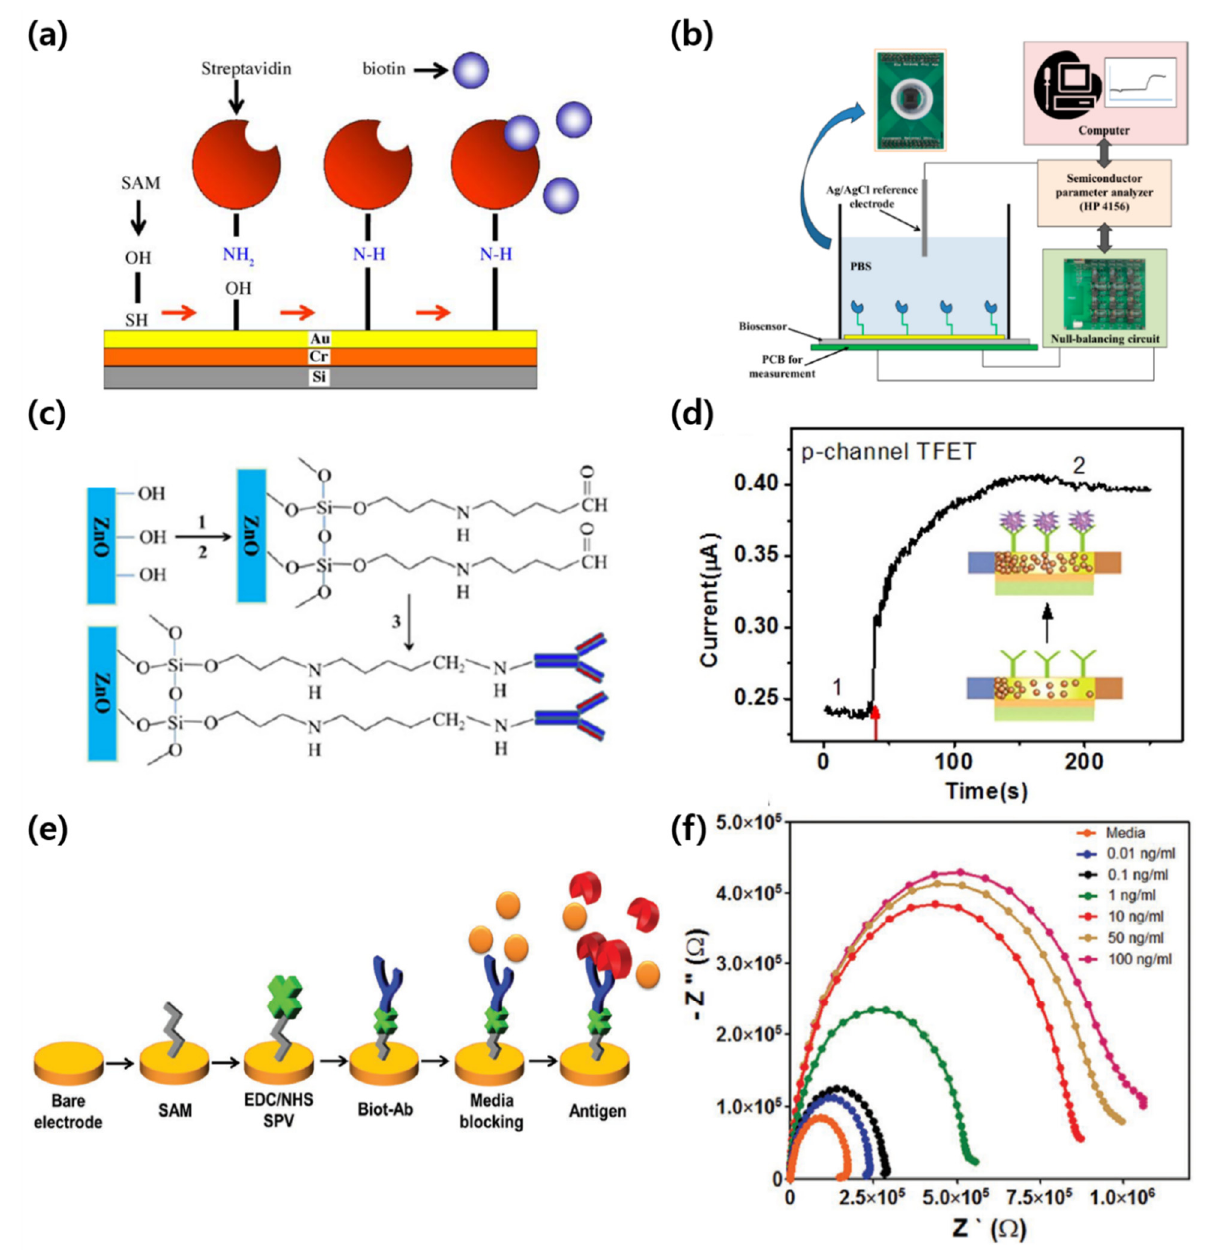
Figure 8. SAMs as a linker in biosensors. ( a ) Schematic of the immobilization sequence of streptavidin and the interaction between streptavidin and biotin (adapted from [93] with permission from Elsevier). ( b ) Measurement setup to detect C-reactive protein (adapted from [94] with permission from MDPI). ( c ) Immobilization of uricase onto the ZnO NW surface via the crosslinking surface modification method: (1) 2% APTES in ethanol; (2) 25 wt% GAD; (3) 5 μ L uricase (5 units/mL) (adapted from [88] with permission from Elsevier). ( d ) Electrical characteristics of an SiNW-TFET based biosensor detecting CYFRA21-1 (adapted from [85] with permission from Springer Nature). ( e ) Illustration of immobilizing antibodies onto the microelectrodes and reacting with antigens (adapted from [95] with permission from John Wiley and Sons). ( f ) Nyquist plots for different standard human albumin concentrations. Media refers to the treatment of cell culture media to prevent the nonspecific binding of proteins (adapted from [95] with permission from John Wiley and Sons).